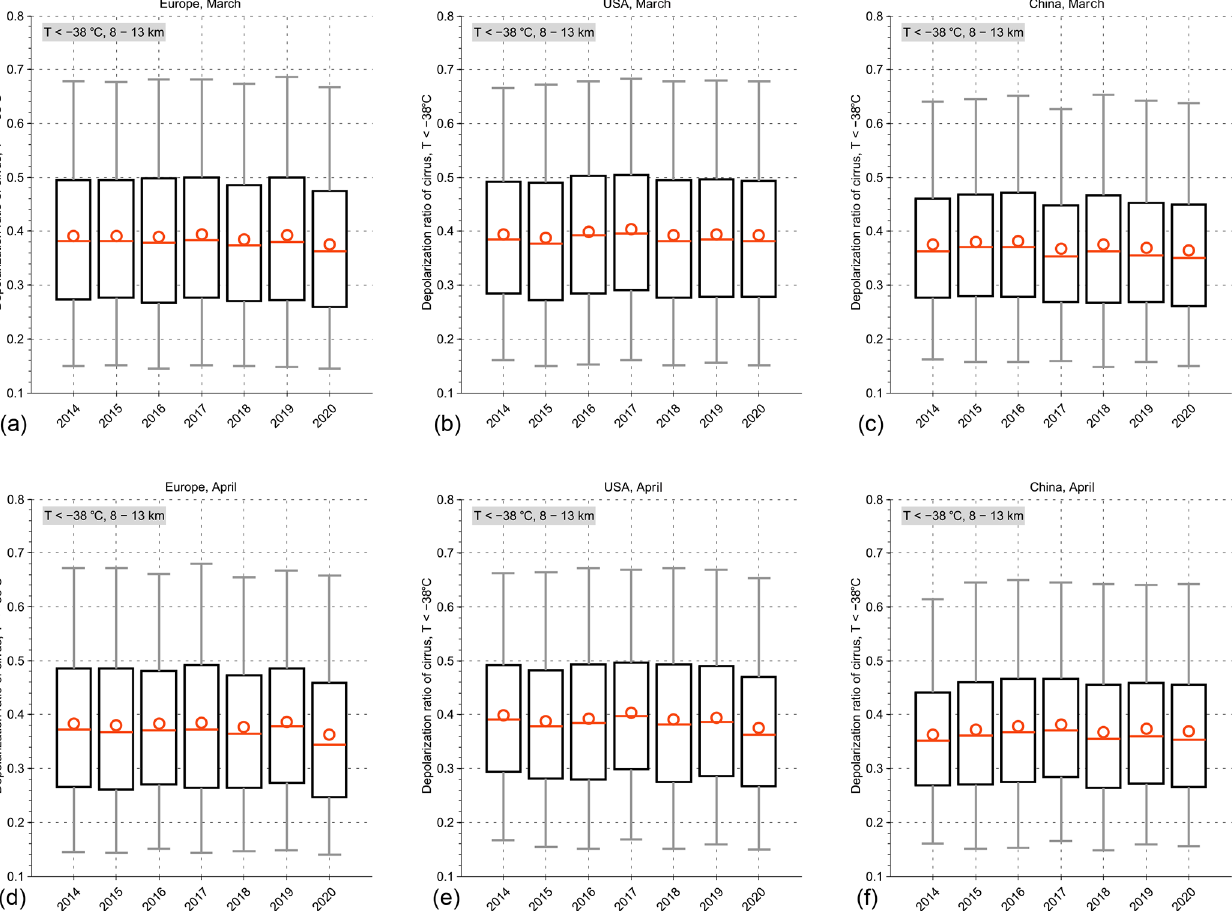
Figure 11. Box plot representations of the PLDR of cirrus clouds detected in the years from 2014 to 2020 over Europe (a, d) , the USA (b, e) , and China (c, f) . Panels (a) – (c) are for the observations in March; panels (d) – (f) are for April. Boxes represent the 25th–75th percentiles (top and bottom), and the solid lines in red through the corresponding boxes stand for the medians and red circles for means. Whiskers in gray indicate the 5th and 95th percentiles, and outliers which are larger than the upper whisker or smaller than the lower whisker are not shown